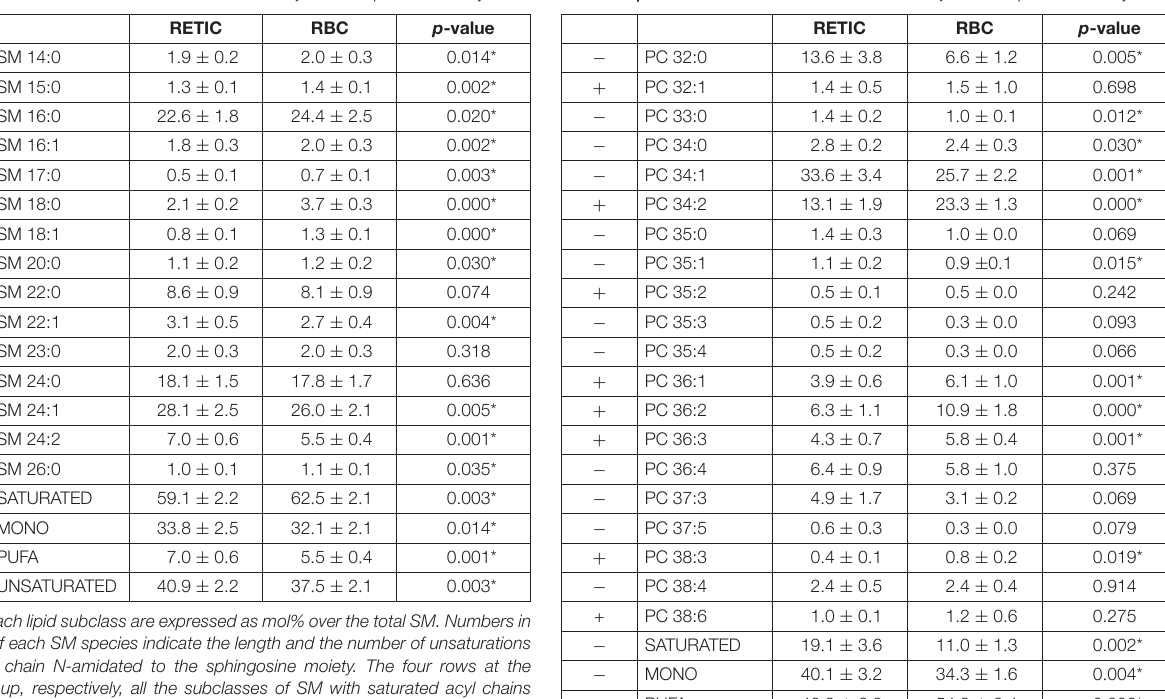
TABLE 4 | SM subclasses in Retics and RBCs subjected to lipidomics analysis. TABLE 5 | PC subclasses in Retics and RBCs subjected to lipidomics analysis.